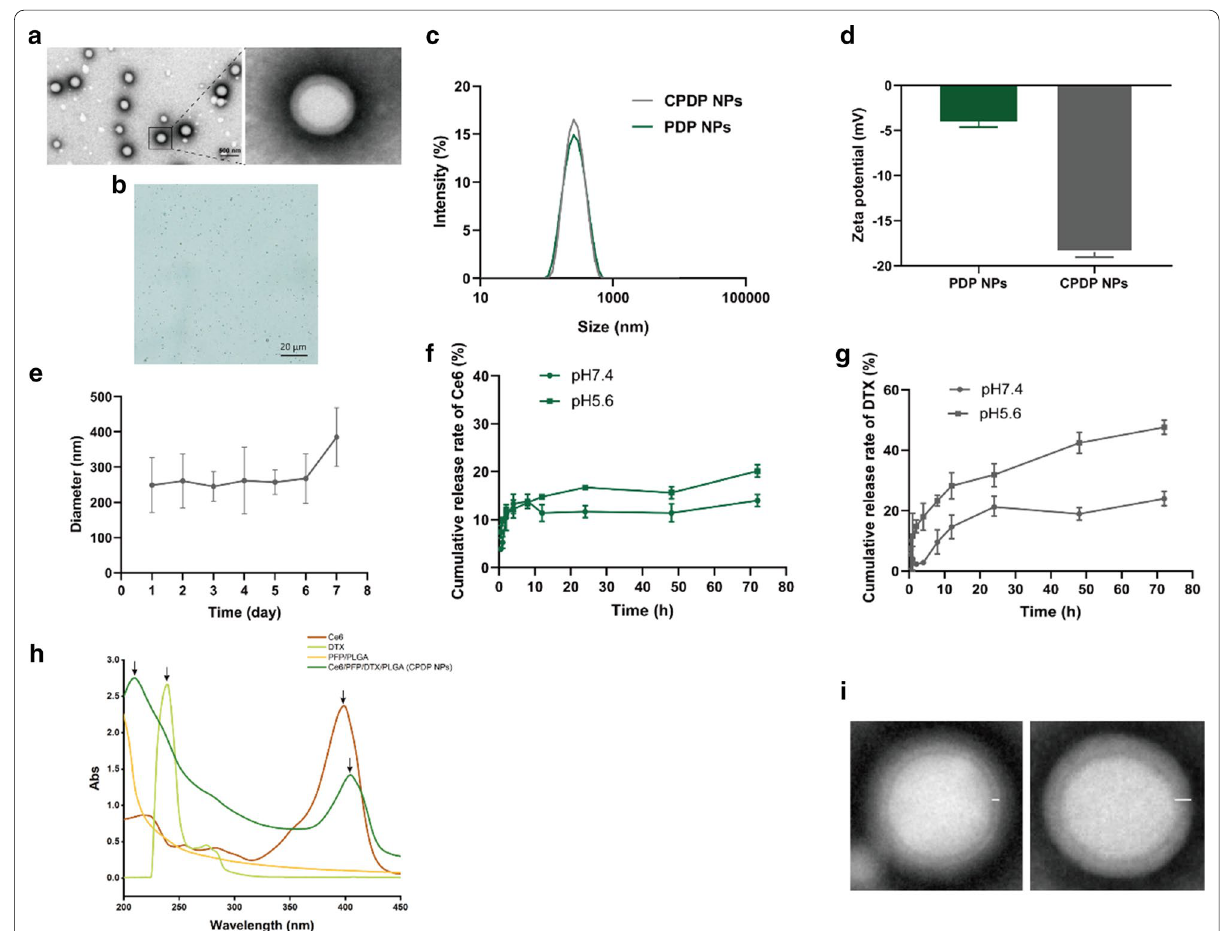
Fig. 1 a TEM (scale bar: 500 nm) and b light microscope image of CPDP NPs (scale bar: 20 μm). c Size distribution and d zeta potential of PDP NPs and CPDP NPs. e The size distribution of CPDP NPs within 7 days. f The releasing rate of Ce6 and g the releasing rate of DTX under different conditions (pH 7.4 and pH 5.6, n 3). h The UV–Vis spectrum of Ce6, DTX, PFP/PLGA and CPDP NPs, respectively. The arrows of CPDP NPs show the = characteristic peaks of Ce6 and DTX, indicating the effective encapsulation of both materials. i The TEM result of two nanoparticles. The PFP/PLGA nanoparticle exhibits the thin shell and the round core (left). The CPDP nanoparticle encapsulated both Ce6 and DTX shows the much thicker shell and the oval-shaped core